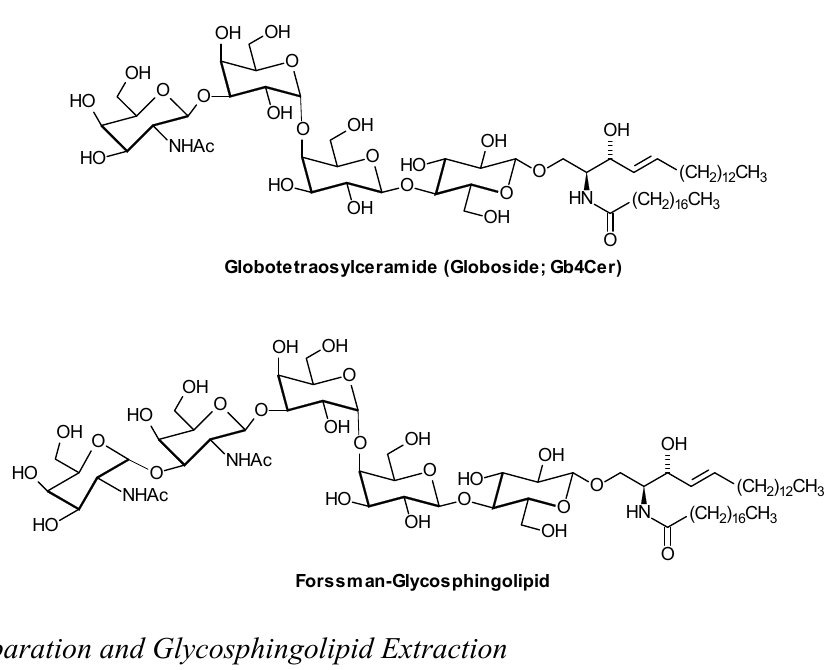
Figure 7. Structures of two globo-series GSLs, Gb4Cer and the Forssman-GSL [26]. Only one of the various lipoforms is shown. Together with ganglioside GM2, Gb4Cer is a major storage substance in Sandhoff disease (  -hexosaminidase  -subunit deficiency). In humans, the Forssman-GSL, a blood group antigen, is present only in trace amounts together with globo-series and Lewis-type blood group glycolipids in the kidney [49]. In sheep, it is mainly responsible for haemolysis of erythrocytes in the presence of Gb4Cer maintaining apical membrane transport, is absent in the plasma membrane of unpolarized MDCK cells and becomes the major GSL in their fully polarized state